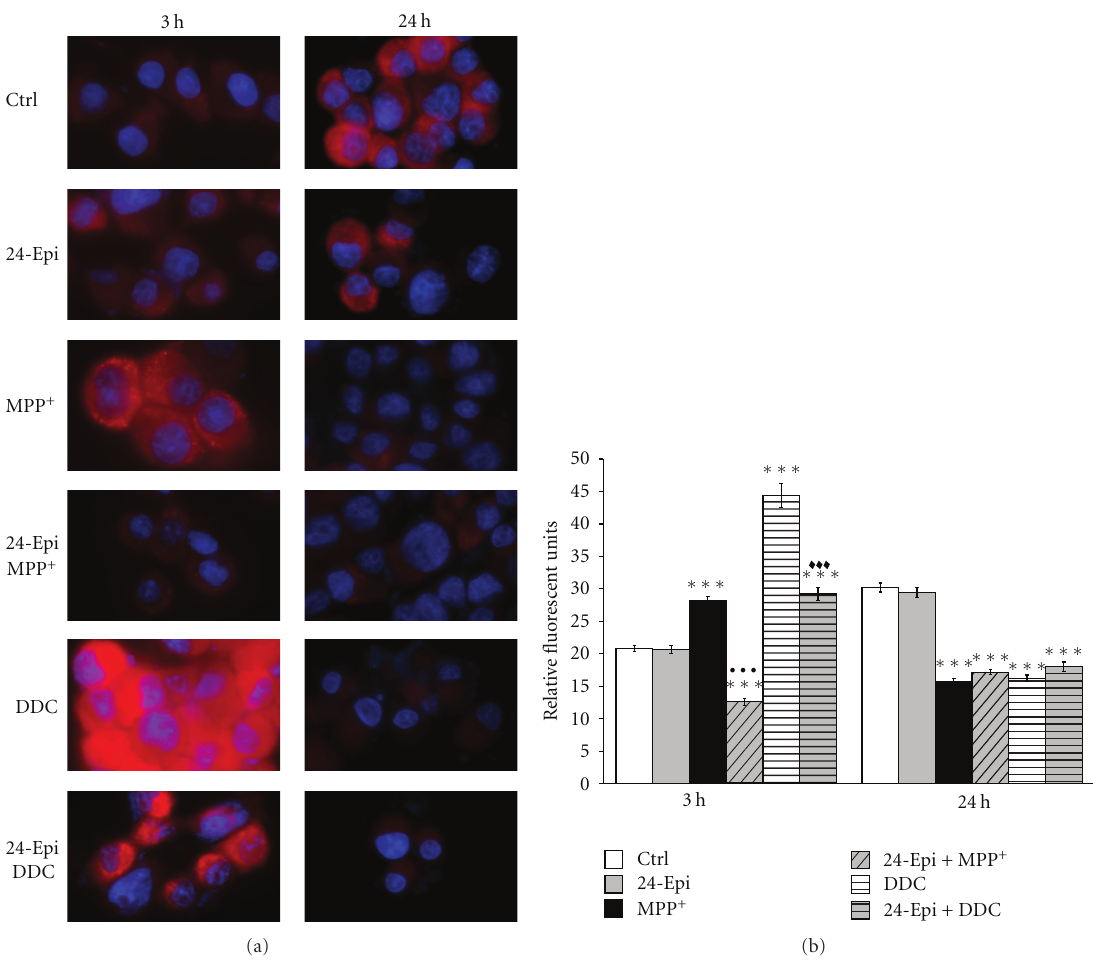
Figure 4: Selective detection of O 2 •− by MitoSOX Red in neuronal PC12 cells. Once in the cells, thisfluorogenic dye is oxidized by superoxide and exhibits red fluorescence. (a) Fluorescence microphotographs at 3-hour or 24-hour treatment. Cells were pretreated with 24-Epi or vehicle (Ctrl) for 3h. Then, they were treated or not with MPP + for 3h or 24h. A significant signal of MitoSOX Red is apparent in neuronal cells treated with MPP + . This signal is much less intense in cells exposed to vehicle (Ctrl) or 24-Epi alone (24-Epi). A marked reduction of red fluorescence is also clear in cells pretreated with 24-Epi and then treated with MPP + (24-Epi + MPP + ). DDC: cells were treated with 80 μ M DDC for 3 h or 24 h. 24-Epi + DDC: cells were pretreated with 10 − 9 M 24-Epi, then with 80 μ M DDC for 3 h or 24 h. (b) Semiquantitative image analysis of fluorescence at 3h and 24h. Nuclei were counterstained in blue with Hoechst 33342. Data are expressed as relative fluorescent units and are means ± S.E.M. Magnification 400x. n = 3. ∗∗∗ P < . 001 versus Ctrl, ••• P < . 001 versus MPP + , and versus